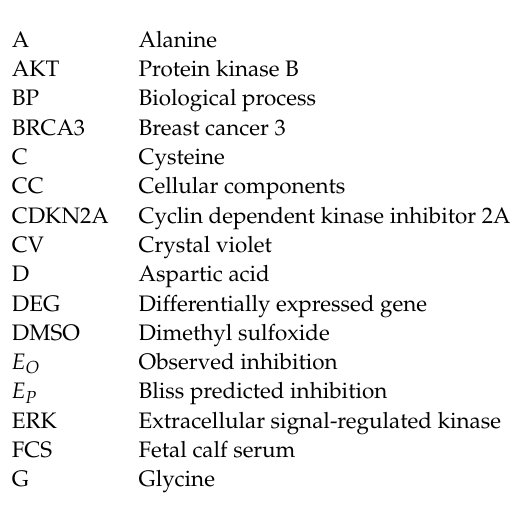
Table S5: Combination Inhibition (Sotorasib + Trametinib + Buparlisib); Table S6: Bliss Independent Model (Sotorasib + Trametinib + Buparlisib); Table S7: Combination Cell Death; Table S8: DEGs of PDAC Cell Lines after Exposure to the Combination of BI-3406, Trametinib and Buparlisib; Table S9: DEGs of MIA PACA-2 after Exposure to the Combination of Sotorasib, Trametinib and Buparlisib; Table S10: GO Enrichment Analysis after PDAC Cell Lines Exposure to the Combination of BI-3406, Trametinib and Buparlisib; Table S11: KEGG Pathway Enrichment Analysis after PDAC Cell Lines Exposure to the Combination of BI-3406, Trametinib and Buparlisib; Table S12: GO Enrichment Analysis after MIA PACA-2 Exposure to the Combination of Sotorasib, Trametinib and Buparlisib; Table S13: KEGG Pathway Enrichment Analysis after MIA PACA-2 Exposure to the Combination of Sotorasib, Trametinib and Buparlisib; Table S14: Cell Viability